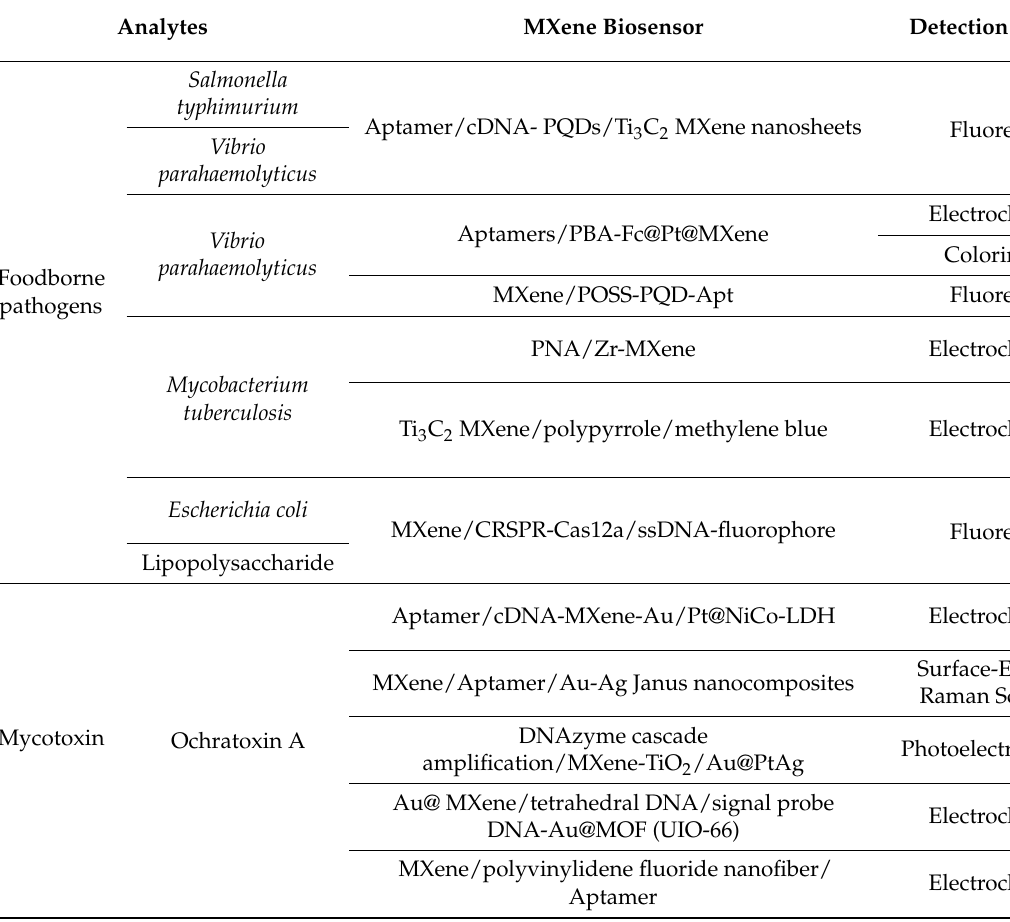
Table 1. Summary of MXene-based NA biosensors for agri-food